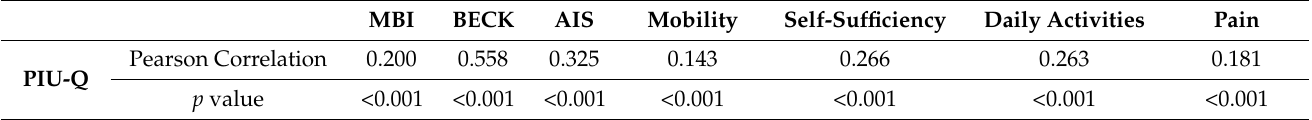
Table 2. Correlation between internet addiction with burnout, depression, insomnia, and quality of life subcategories (PIUQ: Problematic Internet Use Questionnaire, MBI: Maslach Burnout Inventory, AIS Athens Insomnia